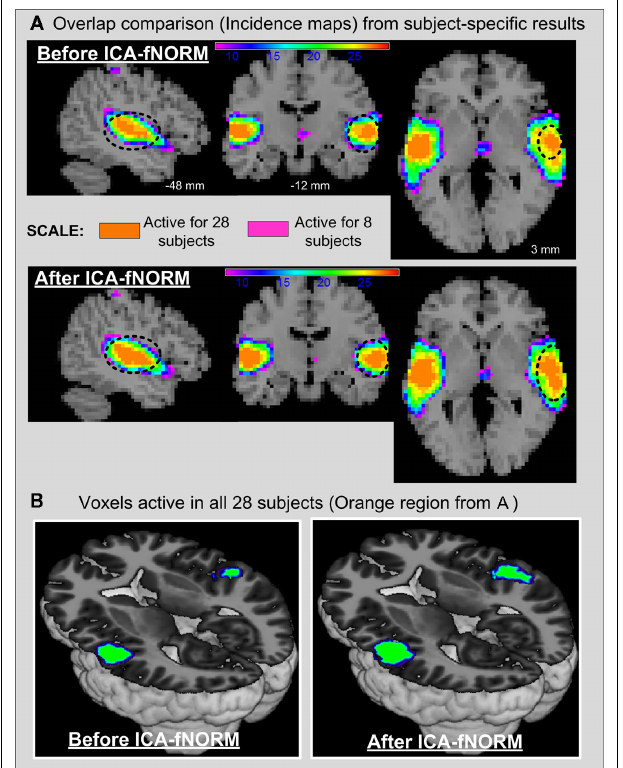
FIGURE 10 | Subject-specific results from all 28 subjects presented using incidence maps from the temporal lobe IC derived from before and after ICA-fNORM data sets. (A) Incidence maps with voxels that overlap in at least 8 subjects (pink) to all 28 subjects (orange). Significant differences near the center of activation clusters are highlighted to illustrate higher functional significance of neighboring voxels after ICA-fNORM is applied. (B) Rendering of voxels from all 28 subjects to highlight the improvement in functional localization at a subject-specific level. More common voxels across subjects are found to be significant after applying